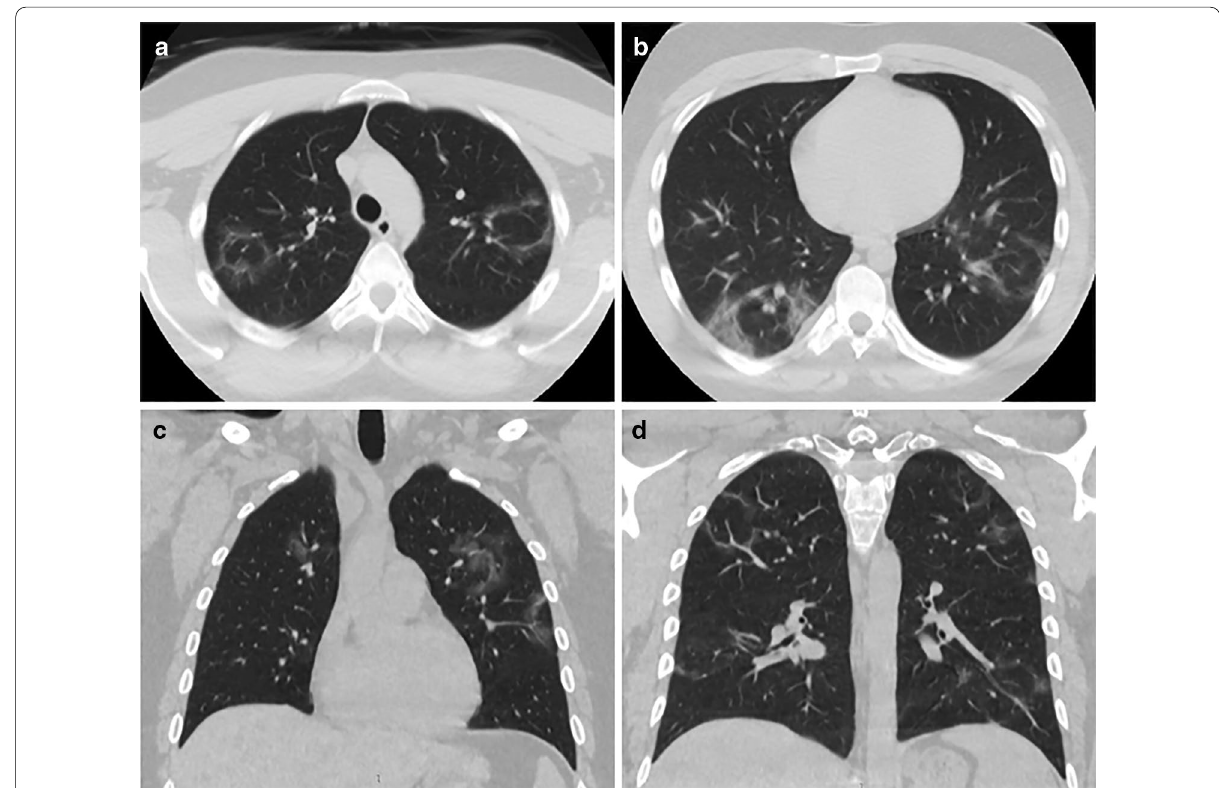
Fig. 2 A 28‑year‑old man with positive RT‑PCR findings for COVID‑19. a – d Noncontrast axial CT images of the chest show bilateral peripheral ground‑glass opacities, bilateral reverse halo sign, and prominent vessel inside. This is in keeping with his CO‑RADS 5 and typical RSNA